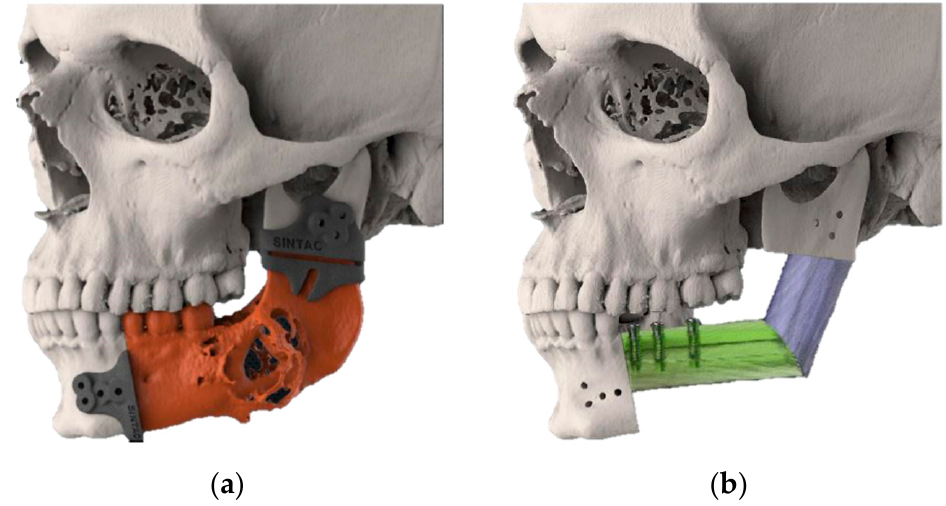
Figure 1. ( a ) Lateral view of resection plans defined by the tumor extent. ( b ) Lateral view of mandibular reconstruction planning with two fibula segments. In the mesial segment, dental implants were placed.